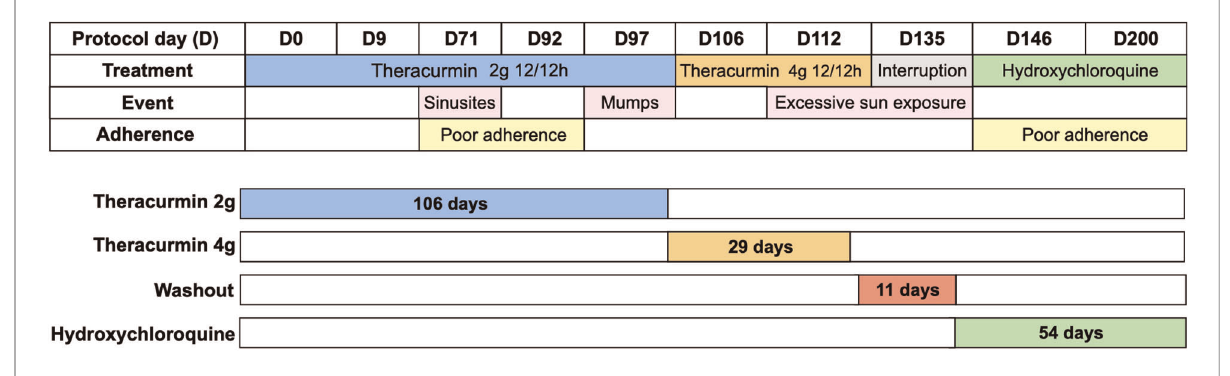
FIGURE 1 Protocol design, evaluation time, therapeutic intervention, events and report of treatment